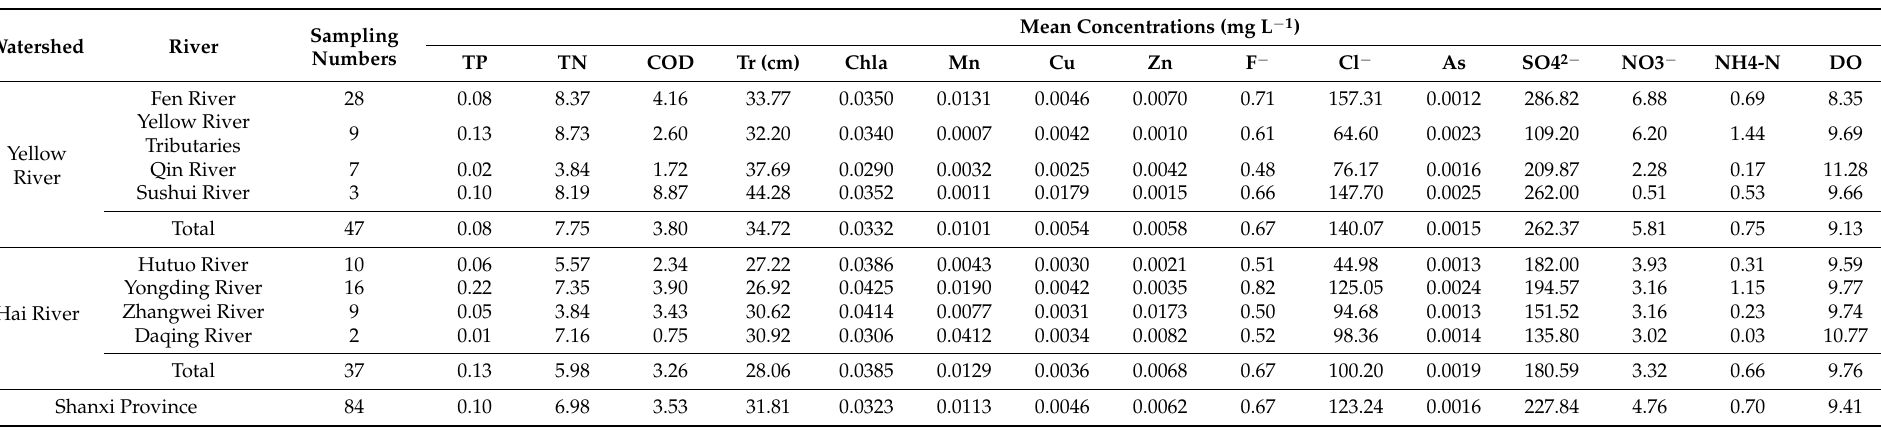
Table 1. Sampling numbers and mean concentration of 15 hydrochemical indices in different watersheds and